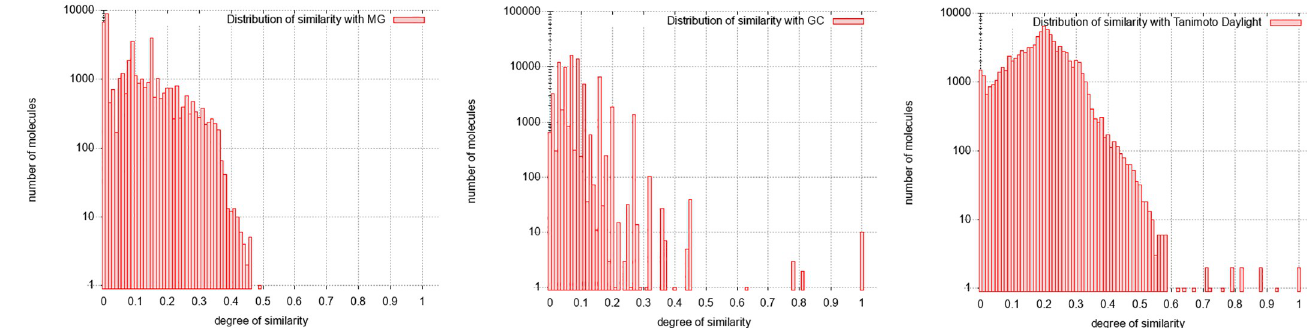
Fig 9. Distribution of similarity on Docetaxel Anhydrous. From left to right: Distribution with molecular graphs (MG), graphs of cycles (GC) and Tanimoto Coefficient (TC).